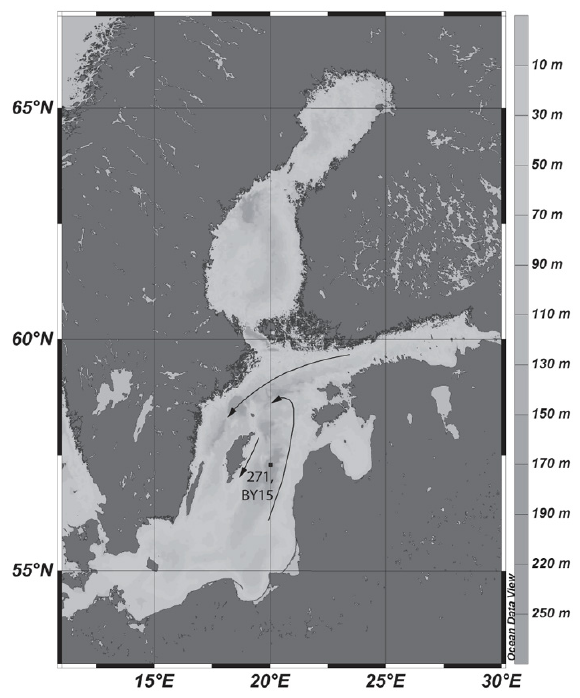
Fig. 1. Bathymetric map of the Baltic Sea with sampling station in the Eastern Gotland Basin and surface currents (Matth¨aus et al., 2008). Bottom currents are